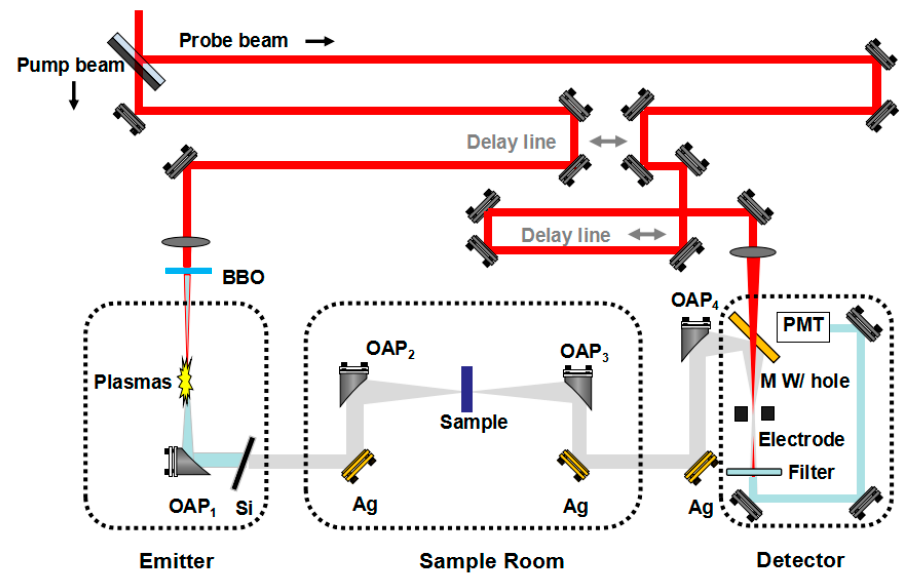
Figure 1. Experimental setup of the broadband THz-TDS based on the THz-ABCD technique.